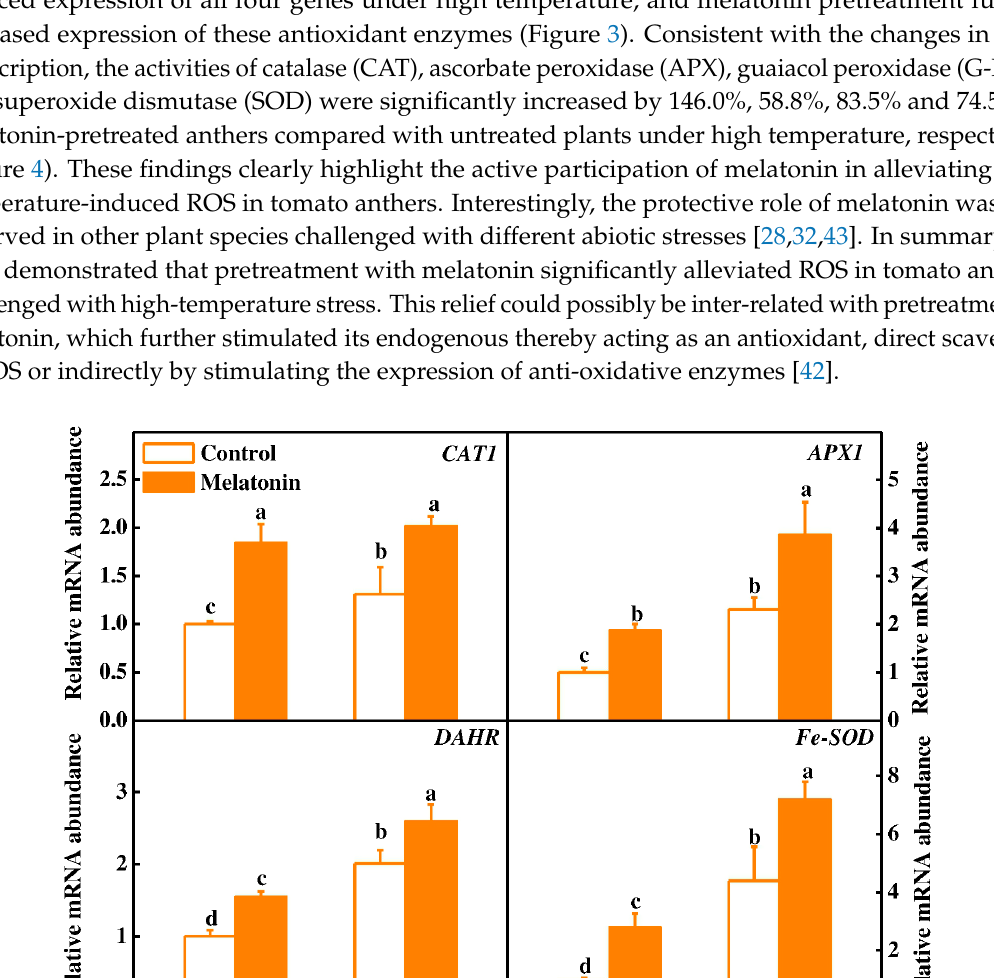
Figure 3. Expression of antioxidant genes in tomato anthers after 3 h high temperature stress. The data shown are the average of four replicates, with the standard errors shown by vertical bars. Means denoted by the same letter did not significantly differ at p < 0.05, according to Tukey’s test.